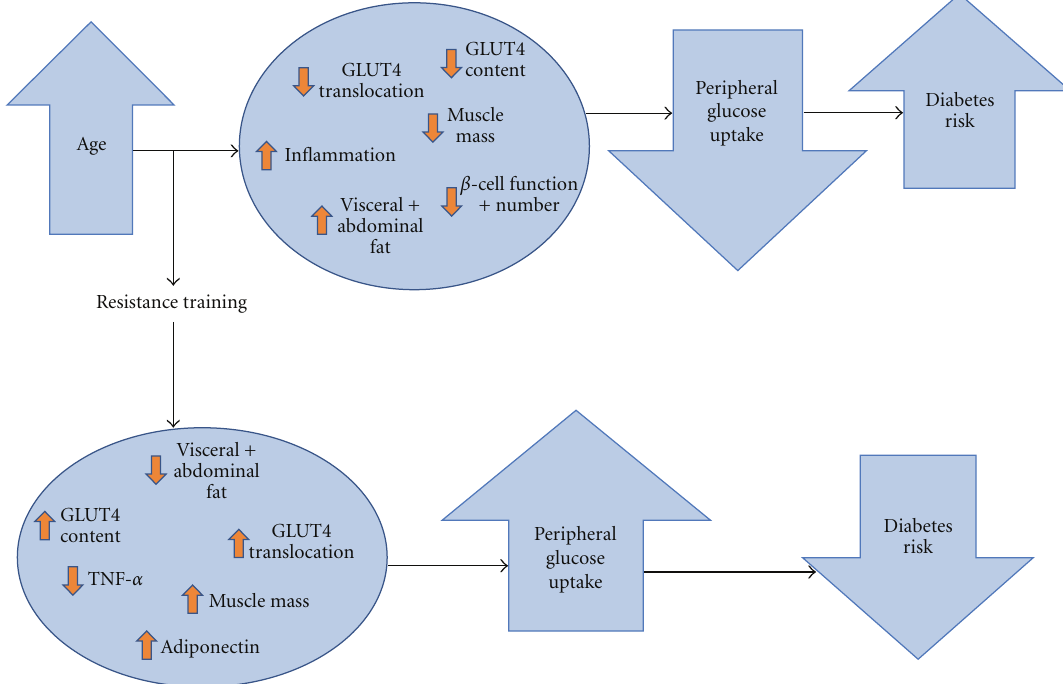
Figure 1: Age-related physiological changes and diabetes risk: Potential influence of